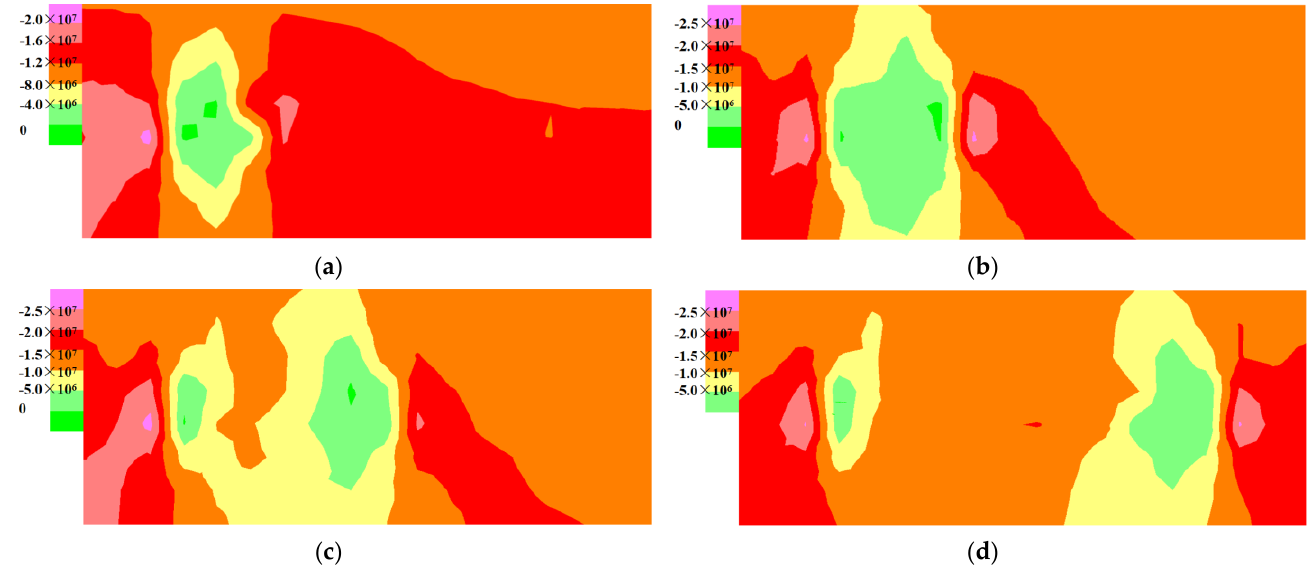
Figure 9. Vertical stress distribution at different distances of working face advancement: ( a ) vertical stress distribution at 30 m of working face advancement: ( b ) vertical stress distribution at 50 m of working face advancement: ( c ) vertical stress distribution at 80 m of working face advancement; and ( d ) vertical stress distribution at 140 m of working face advancement.